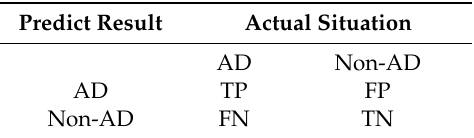
Table 4. The concept of confusion